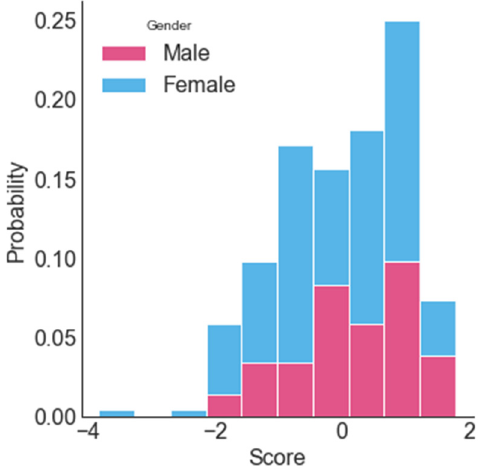
Figure 7. E-commerce awareness and loyalty score distributions. Table 4. Descriptive statistics of the standardized e-commerce awareness and loyalty level